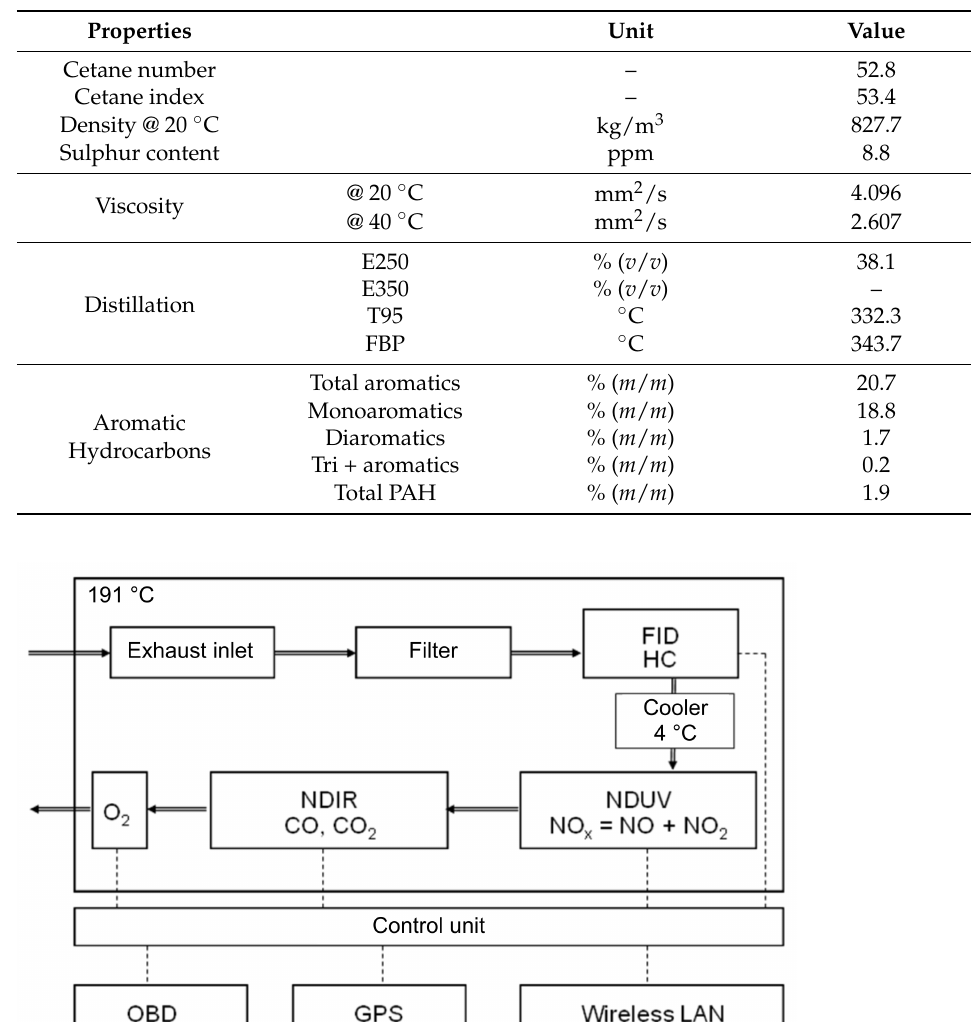
Table 2. Some properties of conventional diesel fuel used in the tests.